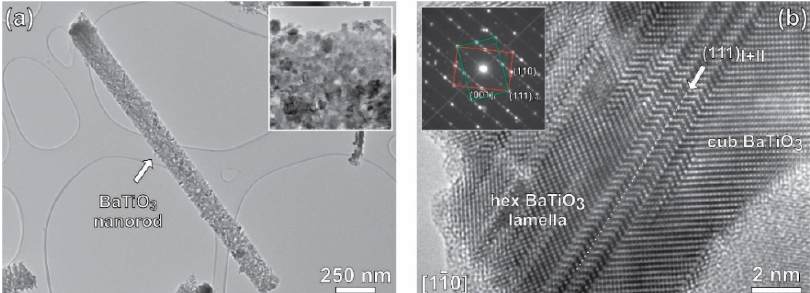
Figure 1. ( a ) Bright-field TEM image of a uniformly shaped and polycrystalline BaTiO 3 nanorod. The inset in the upper right corner shows a higher-magnification bright-field TEM image of polycrystalline BaTiO 3 nanorod with grain sizes in the range from 20 to 50 nm. ( b ) HRTEM image of slabs of hexagonal BaTiO 3 polymorph intergrown with cubic BaTiO 3 as seen in the (1 − 10) zone axis. The inset presents the SAED corresponding to the hexagonal